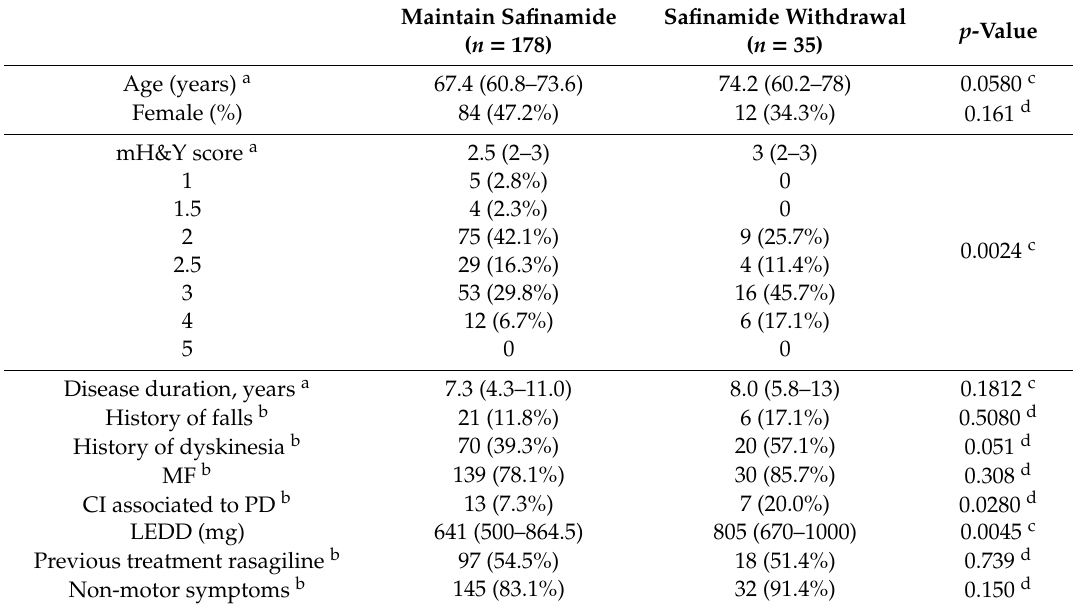
Table 2. Comparison of baseline characteristics between patients who withdrew from safinamide and those who maintained